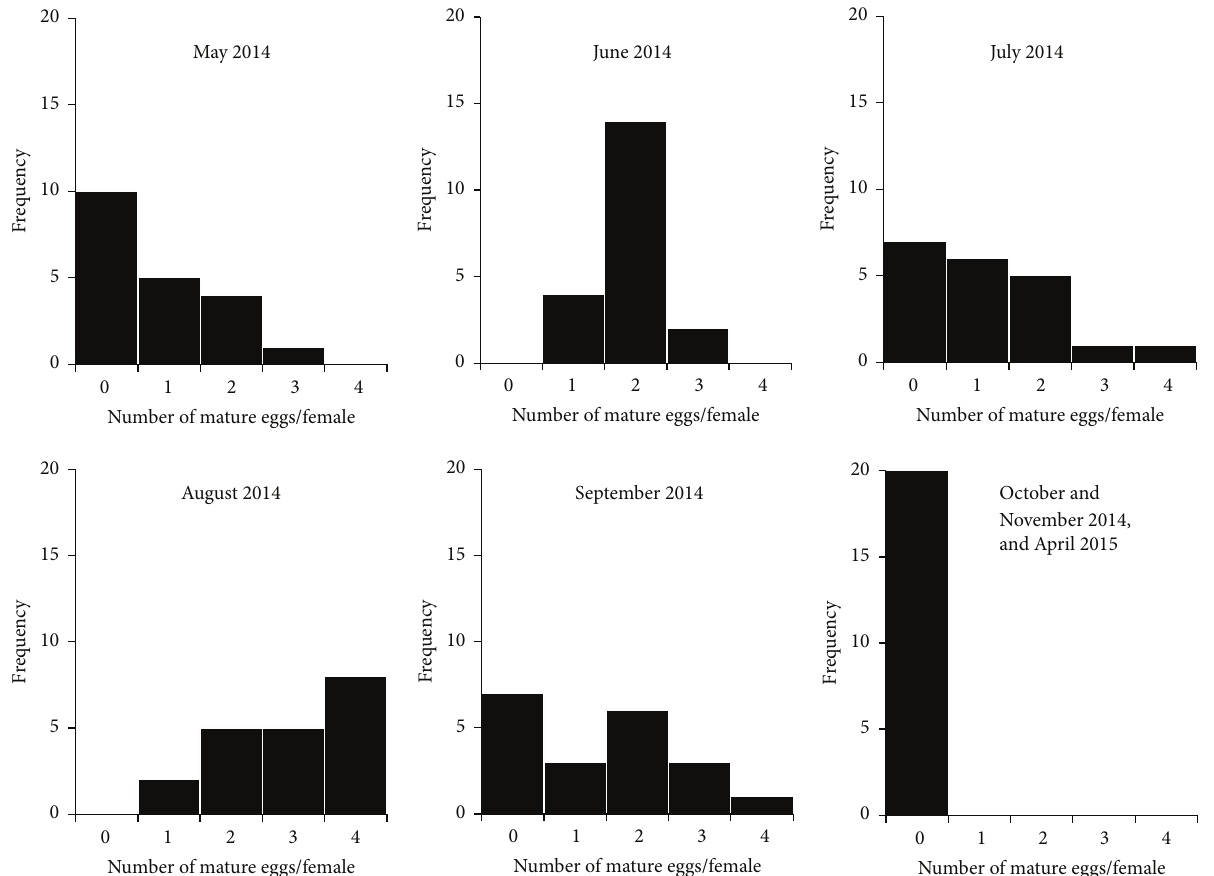
Figure 4: Histogram of number of mature eggs/female from May 2014 to April 2015.